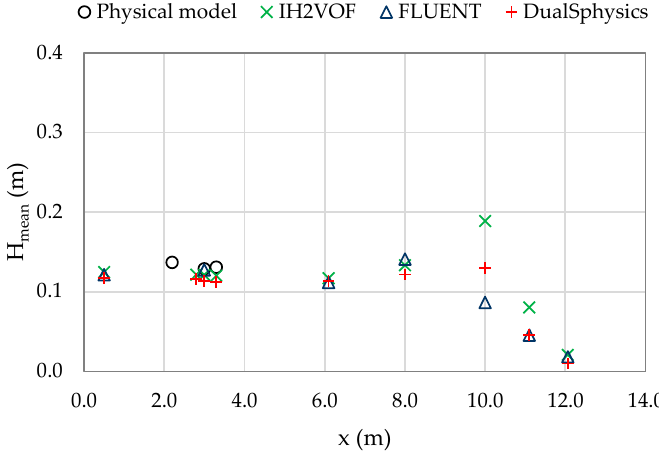
Figure 7. Wave height along the flume for test 1. For test 5, Figure 8, where wave overtopping occurs, the numerical models have higher differences in results for x < 8 m than for the test 1, with differences varying from values less than 7% between FLUENT and DualSPHysics and values up to 25% between IH2VOF and DualSPHysics. Normalised RMSE is 36%. IH2VOF presents higher values of RMSE than IH2VOF and lower than FLUENT and DualSPHysics. As for test 1, x = 10 m is the one with higher differences between the models, due to breaking differences: waves in IH2VOF break after that point and for FLUENT and DualSPHysics, waves broke before. After that, the results become more similar, especially for x = 12 m at the toe of the dike. FLUENT and DualSPHysics present very similar results all around the flume.